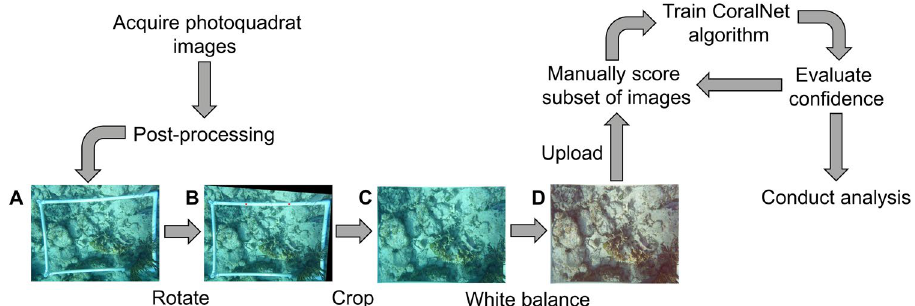
Figure 1. The workflow for the current study. Images of the benthos were taken and post-processed: ( A ) unedited photoquadrat; ( B ) the same photo after it was passed through a program designed to rotate the photo so that the PVC frame is square with the edges of the photo; ( C ) the photo cropped to the inside edge of the frame; and ( D ) the final, color-balanced version of the photoquadrat used for analysis. Post-processed images were uploaded to CoralNet, a subset of which were manually scored to train the algorithm. Images with low confidence were manually scored until all scores were within 50% confidence, which were then used to conduct the